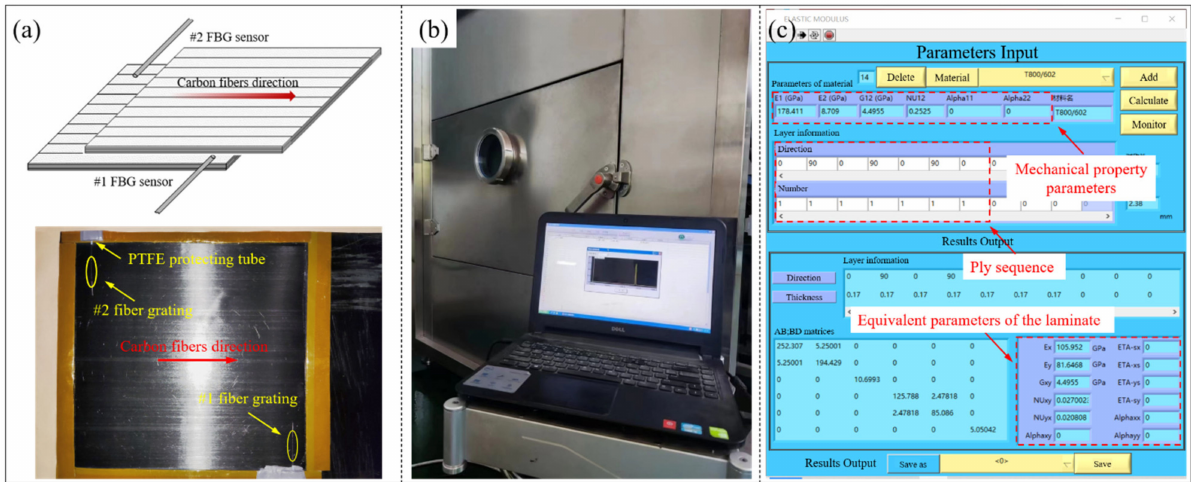
Figure 15. ( a ) Arrangement of the FBG sensors; ( b ) monitoring process during microwave heating of composite laminates; ( c ) equivalent parameters calculation